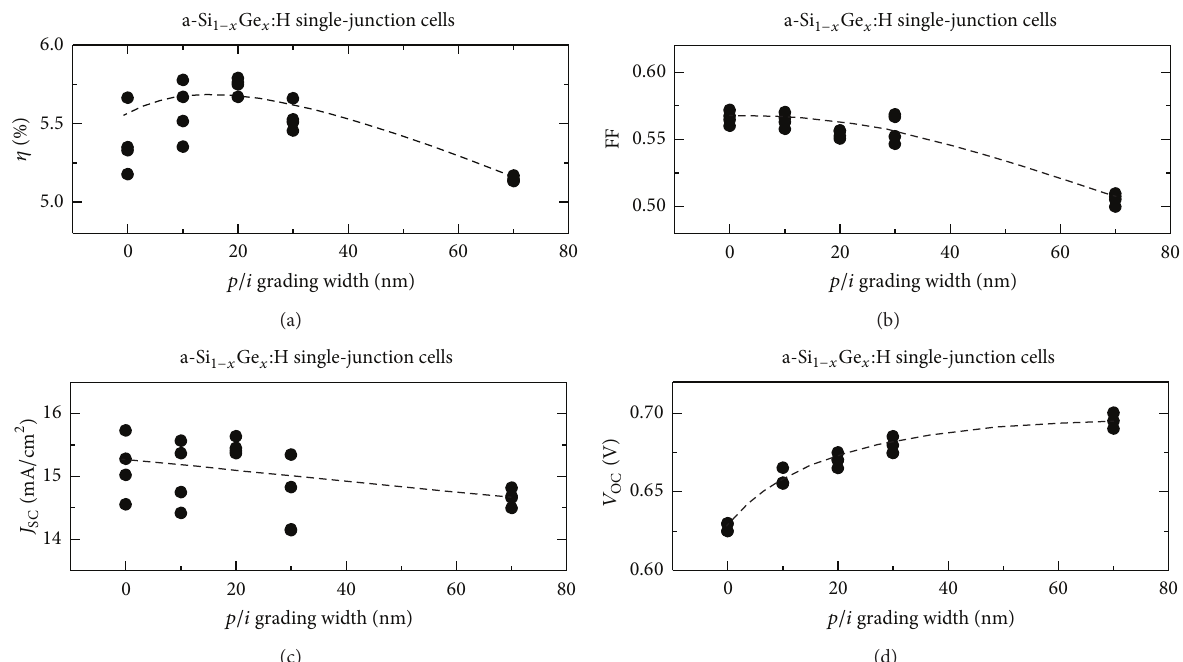
Figure 4: The performance of a-Si 1− Ge :H single-junction cells as a function of the p/i grading width under illumination of AM1.5G light x x source. The p/i grading width was changed from 0 to 70nm meanwhile keeping the total thickness of the absorber at 230 nm for all the cells. The lines were drawn to guide the eye.